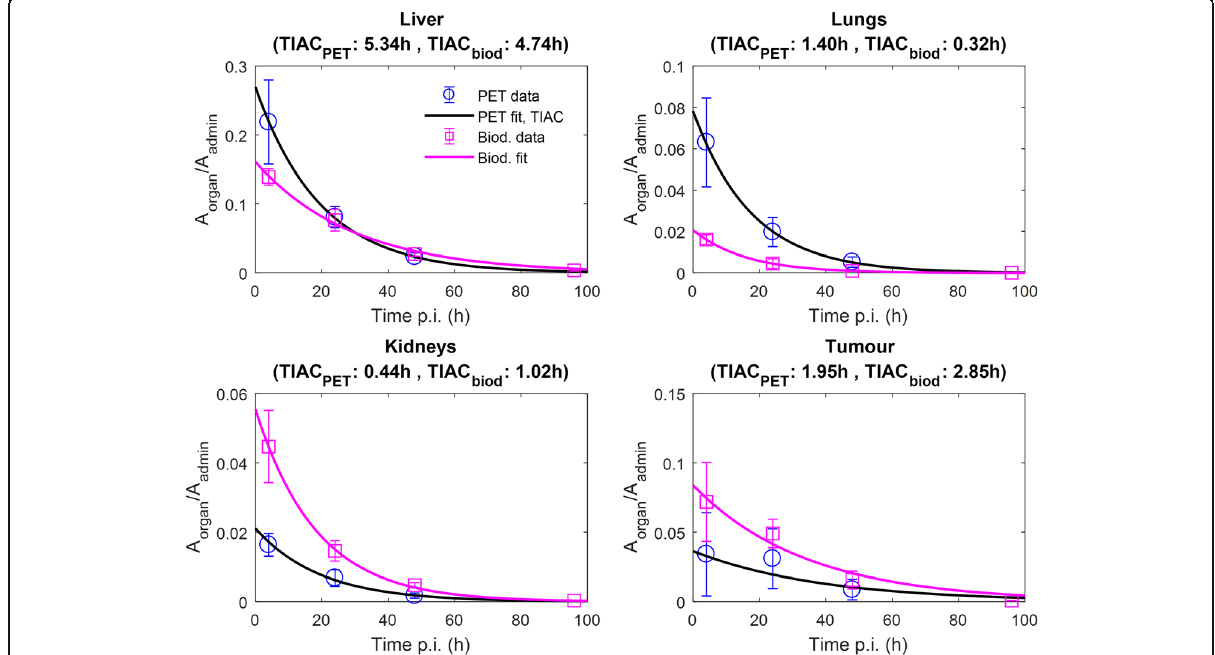
Fig. 5 Normalized time-activity curves (nTAC) obtained for most relevant organs. The organ activity was normalized to the mice administered activity. Normalized activity time-points derived from PET are labeled with circles, while squares indicate data obtained from biodistribution experiments. Mean ± SD are reported for each time point. Full lines represent nTAC mono-exponential fits. The goodness of the fits was expressed by the R 2 metric. R 2 was > 0.96 for all fits calculated for the liver, lungs, and kidneys. R 2 for the biodistribution-derived tumor nTAC fit was 0.97, whereas R 2 for the imaging-derived tumor nTAC fit was